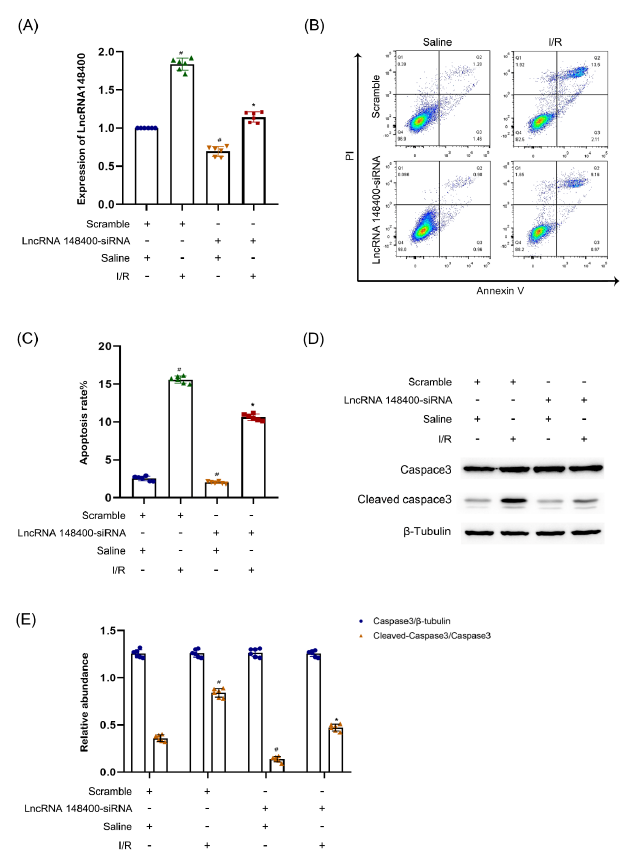
Figure 2. LncRNA148400 siRNA attenuates I/R induced BUMPT cell apoptosis. BUMPT cells were transfected with 100 nM lncRNA148400 siRNA or scramble, and then subjected to I(2 h)/R(2 h) injury. ( A ) RT − qPCR analysis of the expression of LncRNA 148400. ( B ) FCM analysis of apoptosis in BUMPT cells. ( C ) Representative apoptosis rate (%). ( D ) The immunoblot analysis of caspase